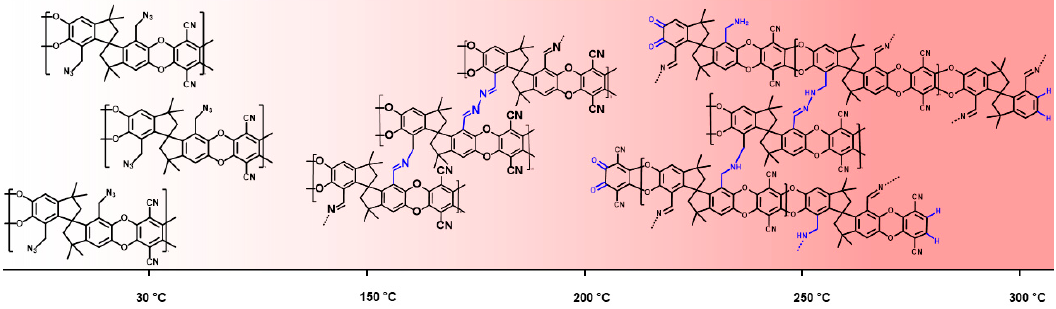
Figure 5. Expected structures of AZ-PIMs at different temperatures.